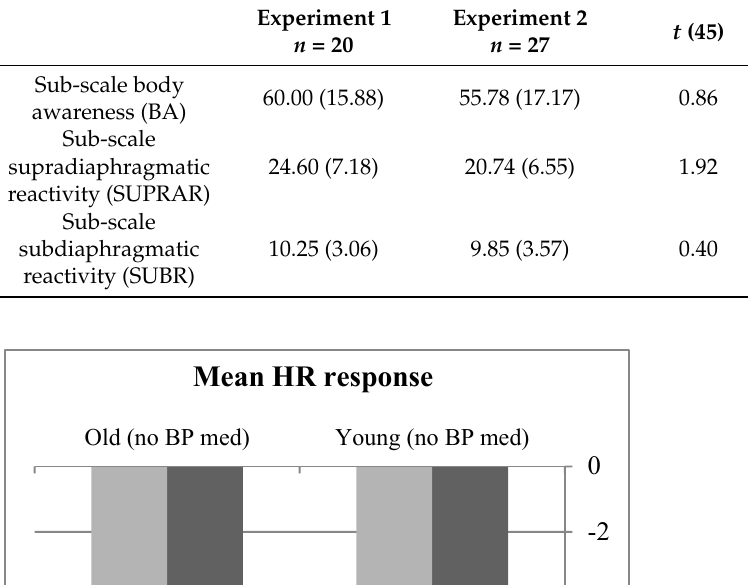
Table A5. Means, standard deviations (SD), statistical parameters, and significance levels of the BPQSF subjective ratings in experiments 1 and 2.